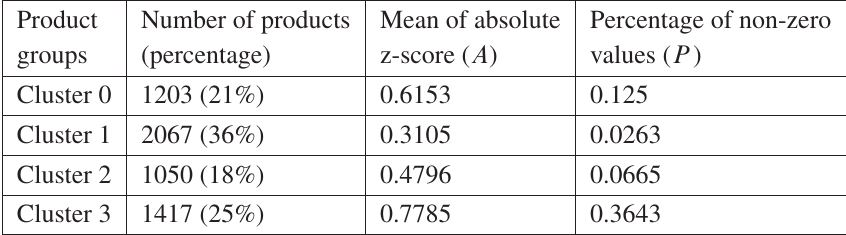
Table 8. Tier-1 weekly stability analysis with the EM algorithm in 2005.